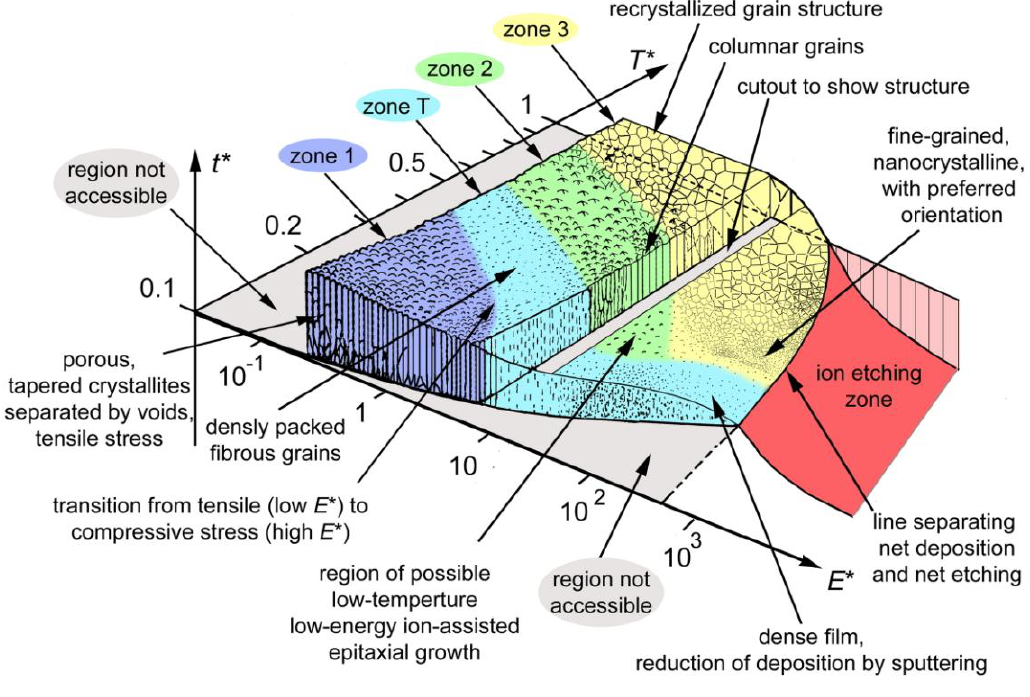
Figure 9 . Structure zone diagram applicable to energetic deposition as a function of the generalized temperature T and the normalized energy flux E ; t represents the net thickness. The boundaries between zones are gradual and for illustration only. Reprinted from [22], Copyright 2010, with permission from